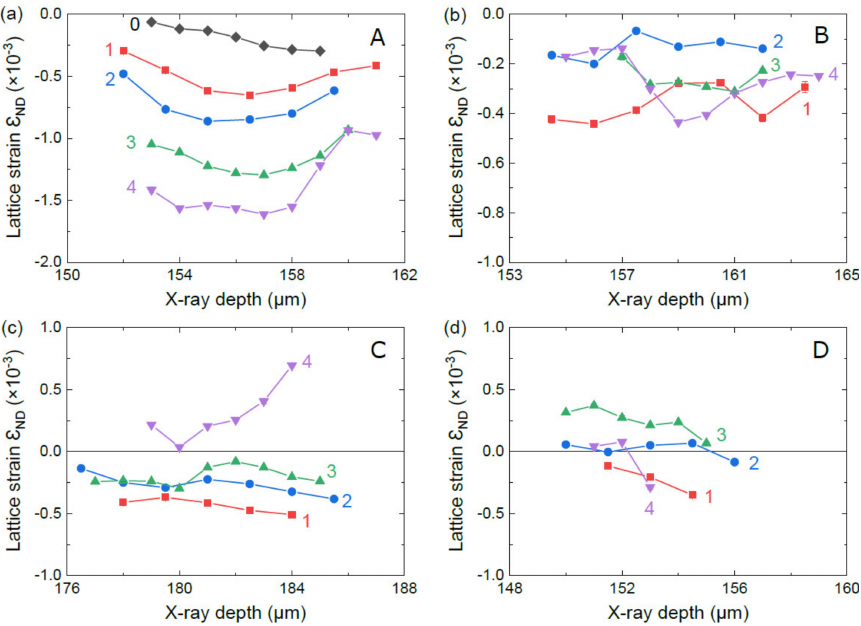
Figure 12. Depth-resolved lattice strain ε ND in four Ti grains in the Ti layer below the Al layer after 1-4 steps of tensile loading. ( a ) (20–29) reflection of grain A; ( b ) (31–47) reflection of grain B; ( c ) (31–47) reflection of grain C; ( d ) (35–26) reflection of grain D. The lattice strains before tensile loading (step 0) are also shown in ( a ). The strain accuracy of the technique is 1 × 10 − 4